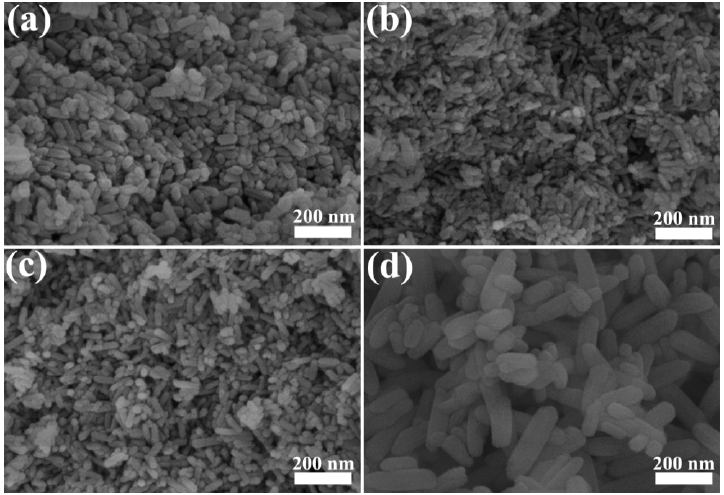
Figure 3. Scanning electron microscopy (SEM) images of the synthesized samples: ( a ) HA-1, ( b ) HA-2, ( c ) SrHA-1, and ( d ) SrHA-2. SrHA-2 exhibited a nanorod shape and had a larger size than the other three.